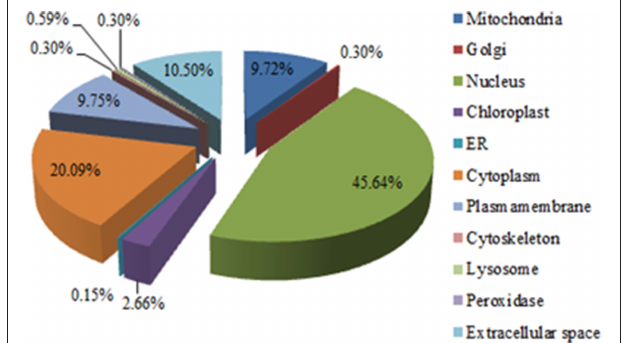
interaction network provides clues for further illumination of the pathogenic mechanism and immunomodulation between CDV and the mink